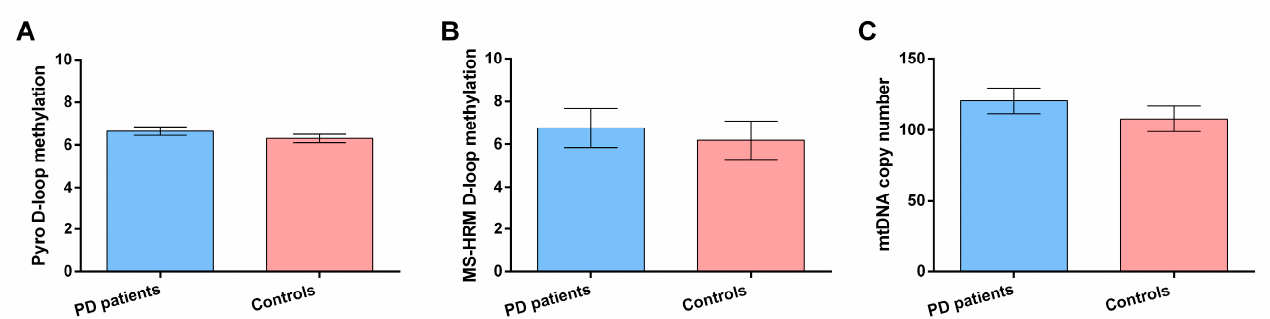
Figure 1. Pyrosequencing ( A ) and MS-HRM ( B ) D-loop region methylation levels and mtDNA copy number ( C ) in PD patients ( n = 30) and control subjects ( n = 30). Data are expressed as mean ± SEM. Statistical analysis was performed by means of Analysis of covariance (ANCOVA), including age at sampling and sex as covariates.